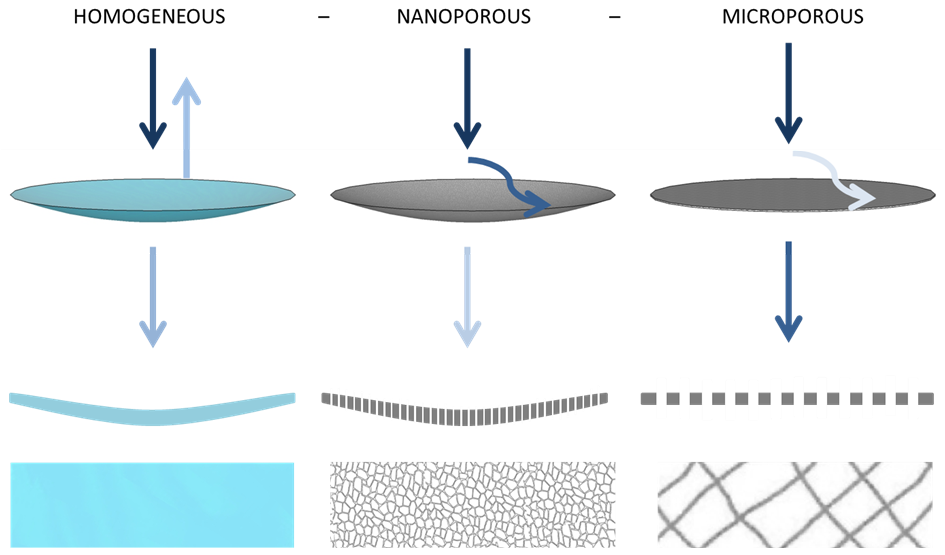
Figure 1. Diagram of the principle of sound absorption by the thin layers of a homogeneous film, a nanoporous membrane, and a microporous layer.